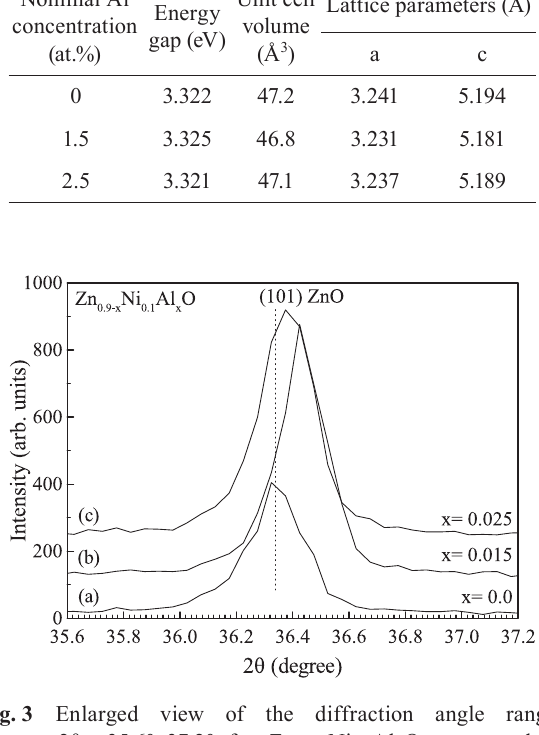
Fig. 3 Enlarged view of the diffraction angle ranges 2θ = 35.6°–37.2° for Zn 0.9-x Ni 0.1 Al x O nanopowders: (a) x = 0.00; (b) x = 0.015 and (c) x = 0.025.